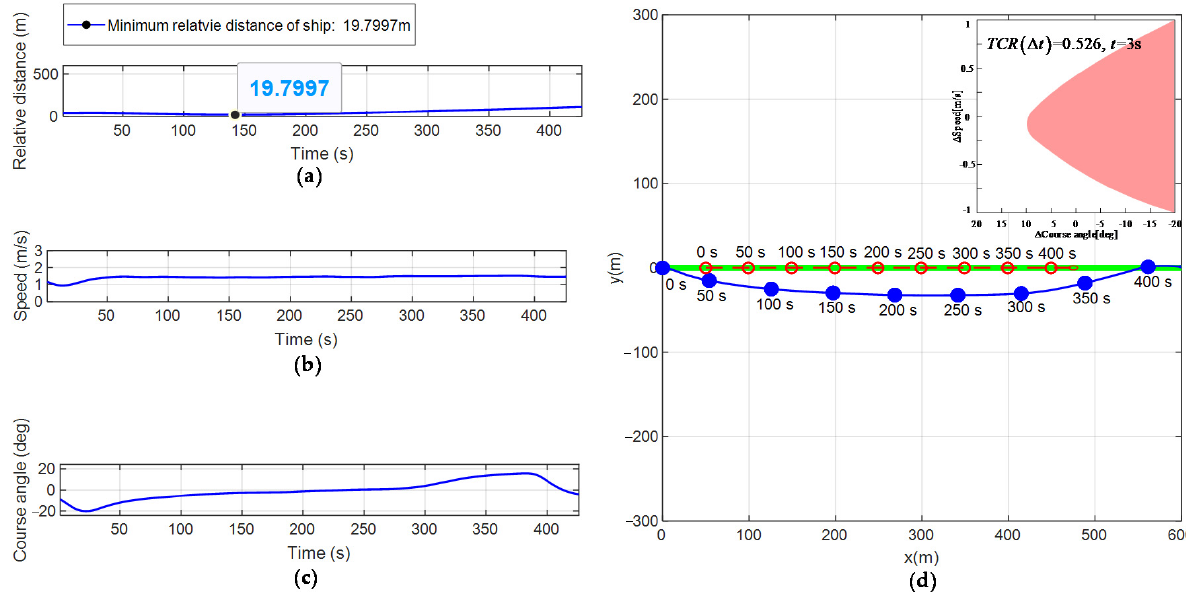
Figure 11. Obstacle avoidance process in the head-on encounter scenario. ( a ) Relative distance; ( b ) Change of velocity; ( c ) Change of yaw angle; ( d ) Obstacle avoidance process.